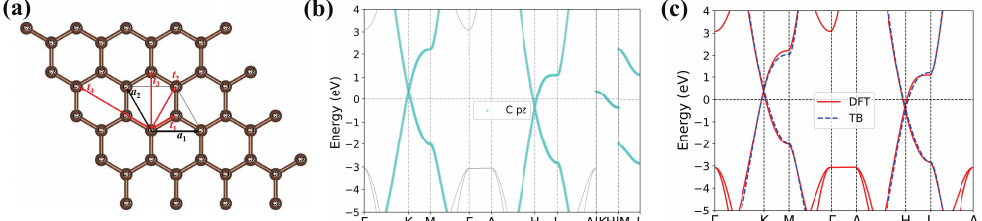
Figure 1. Lattice and electronic structure of AA-graphite. ( a ) Top view of atomic structure of AA- stacking graphite. The primitive cell, lattice vectors a 1 , a 2 and in-plane hopping t are indicated. ( b ) Band structure of AA-stacking graphite, with the corresponding p z orbitals in cyan. The size of the symbol represents the orbital weight. ( c ) Comparison of the band structure for AA-stacking graphite obtained from DFT (red line) and TB (blue dashed line) calculations, respectively.